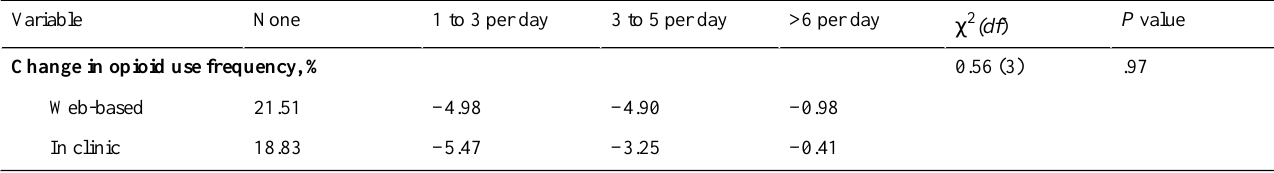
Table 3. Unadjusted comparisons for change in opioid use frequency between online integrated practice unit and in-clinic integrated practice unit